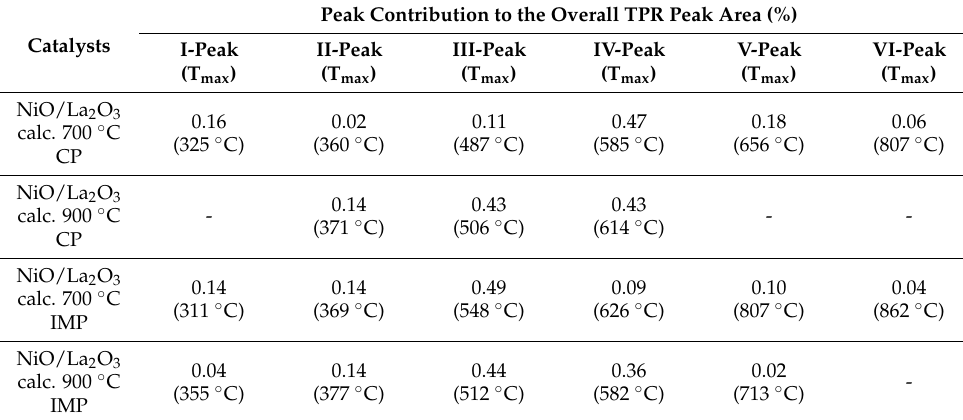
Table 3. Reduction data for the investigated NiO/La 2 O 3